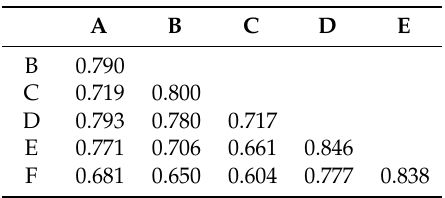
Table 2. Similarity between distributions calculated from Equations (6) and (7), and the fractional contributions in Table